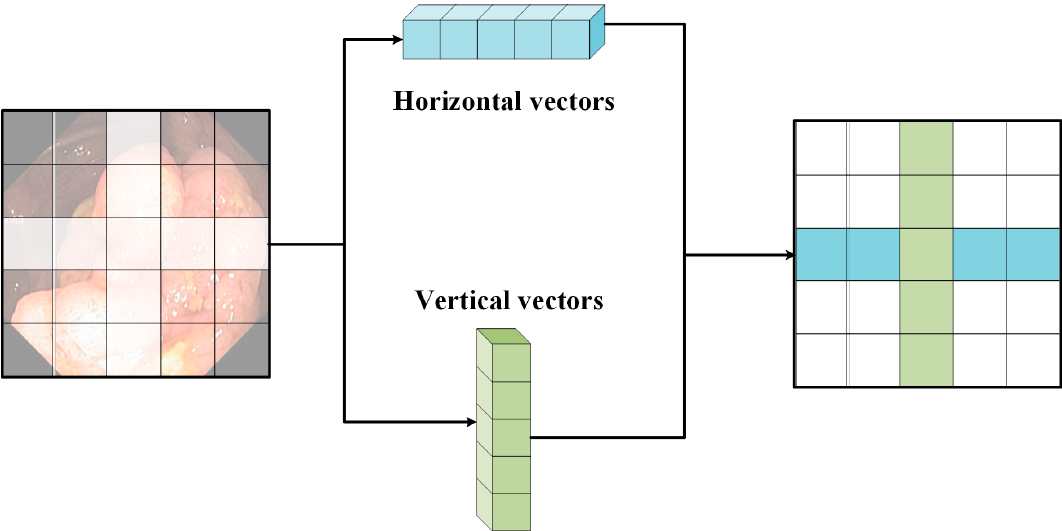
Figure 3. The illustration of Cross-Shaped Window Self-Attention mechanisms.